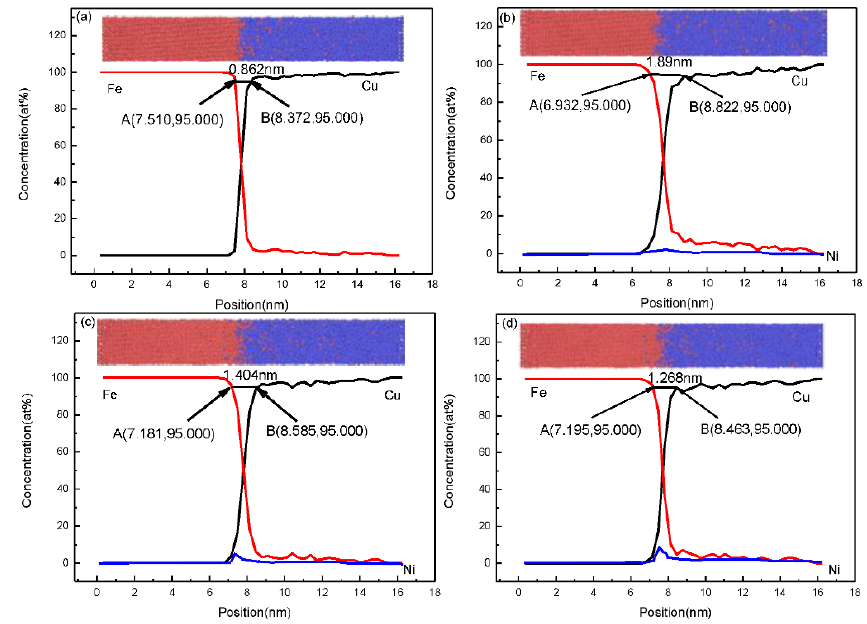
Figure 8. Concentration distribution and the diffusion distance of Fe atoms, Ni atoms, and Cu atoms at 1523 K with different concentrations of nickel atoms: ( a ) for 0% Ni; ( b ) for 1% Ni; ( c ) for 2% Ni; ( d ) for 3% Ni.